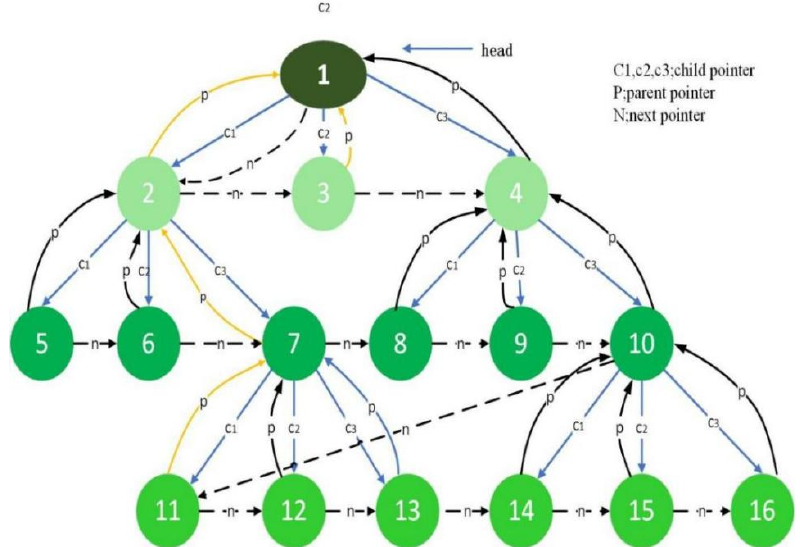
Figure 6. Game expansion tree of ship A and ship B.